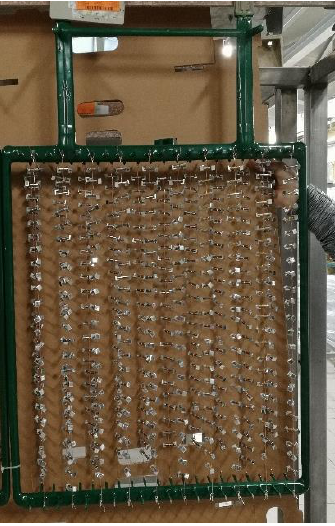
Figure 1. Typical galvanic frame.